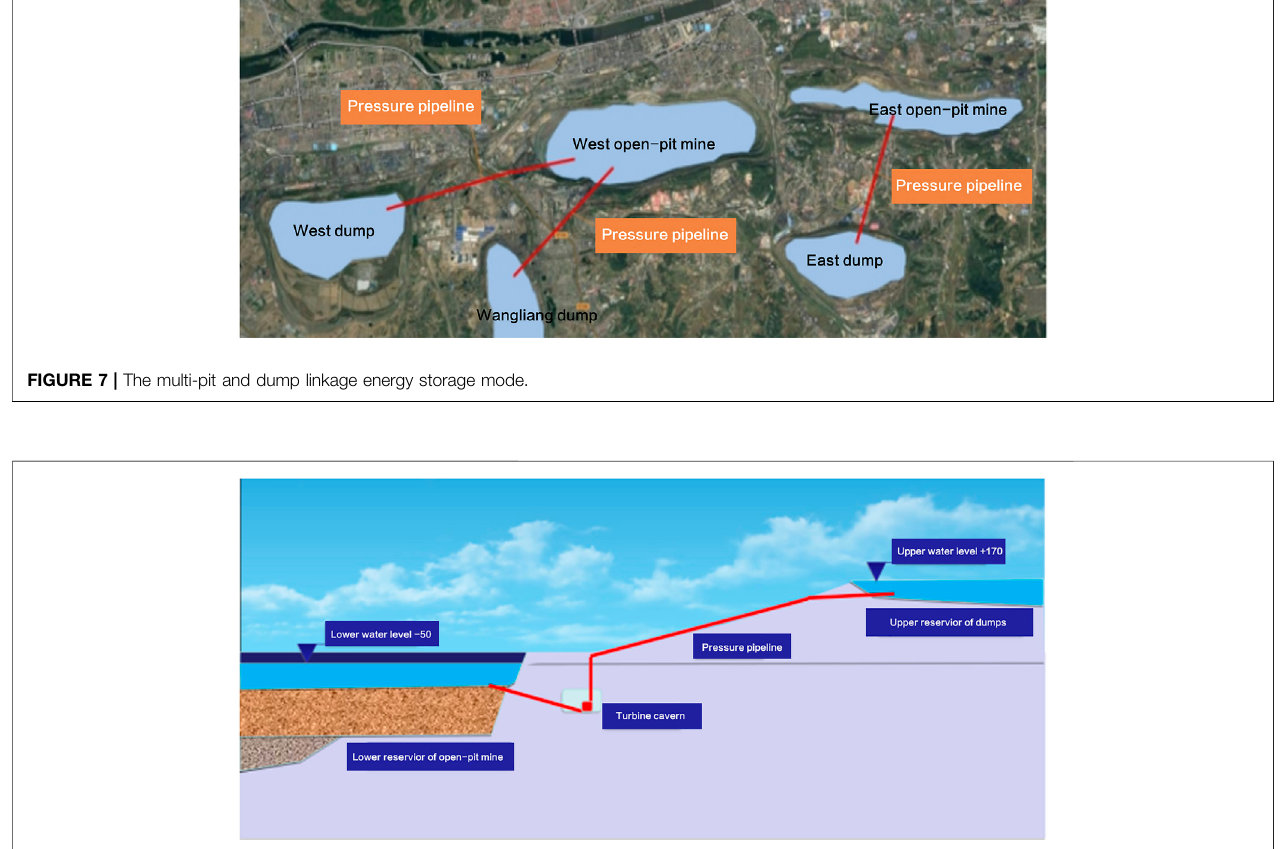
FIGURE 8 | Schematic diagram of the linkage energy storage mode system between multi-pit and dump.